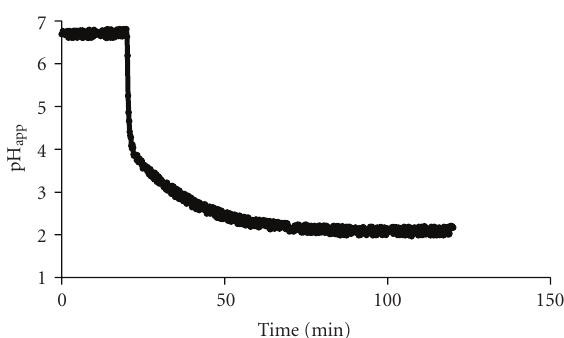
Figure 2: [KI] = 4.8 · 10 − 1 mol/dm 3 ; [PdI 2 ] if all dissolved = 2.66 · 10 − 3 mol/dm 3 ; CO flow = 6mL/min; 25 mL of water.